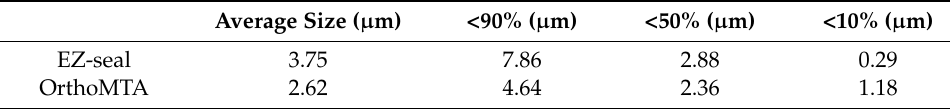
Table 6. Particle size ( µ m) of EZ-seal and